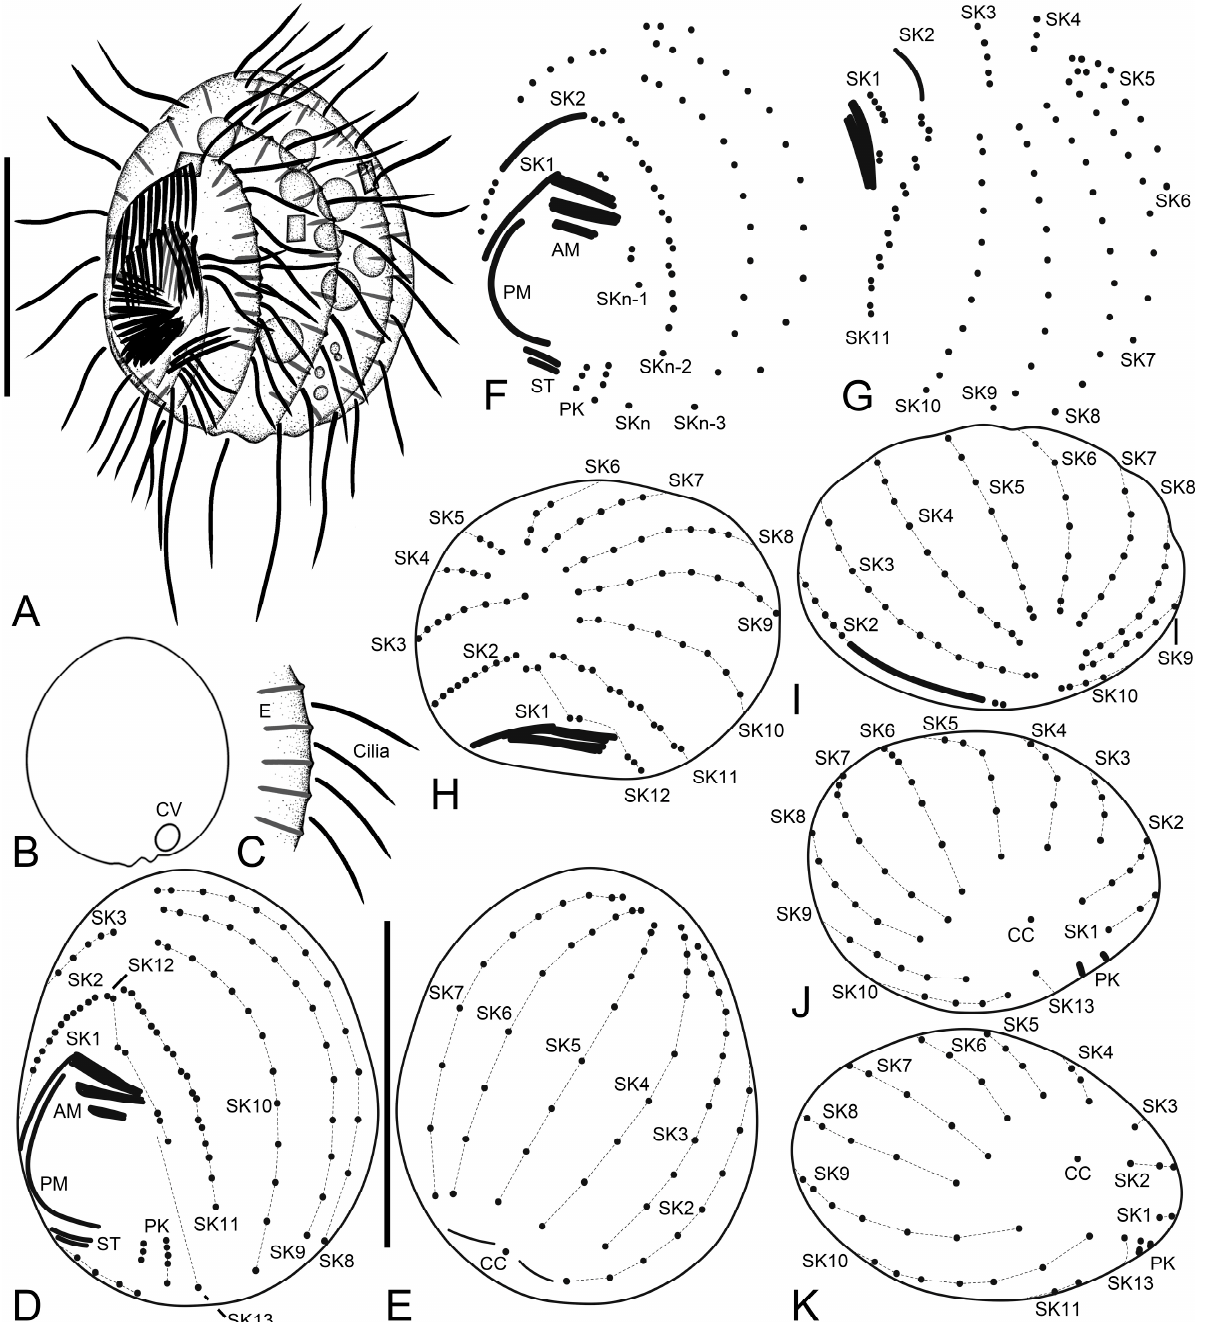
Figure 1. Cinetochilides minimus sp. nov. from life ( A – C ) and after protargol impregnation ( D – K ). ( A ). A representative specimen showing the body shape, cilia, and extrusomes. ( B ). Dorsal view showing the contractile vacuole. ( C ). Extrusomes. ( D , E ). Ventral ( D ) and dorsal ( E ) view of the holotype. ( F – K ). Ventral ( F ), apical ( G – I ), and posterior polar ( J , K ) views of paratype specimens, showing the basal bodies. Dotted lines connect the basal bodies in each somatic kinety as inferred after wet silver nitrate impregnation, especially for somatic kineties n and n-1. Adoral membranelles, paroral membrane, polymerized kinetids, and scutica are shown in thick black lines because the basal bodies are very close together. AM, adoral membranelles; CC, caudal cilium; CV, contractile vacuole; E, extrusomes; PK, postoral kineties; PM, paroral membrane; SK, somatic kineties; ST, scutica. Scale bars: 10 µm.